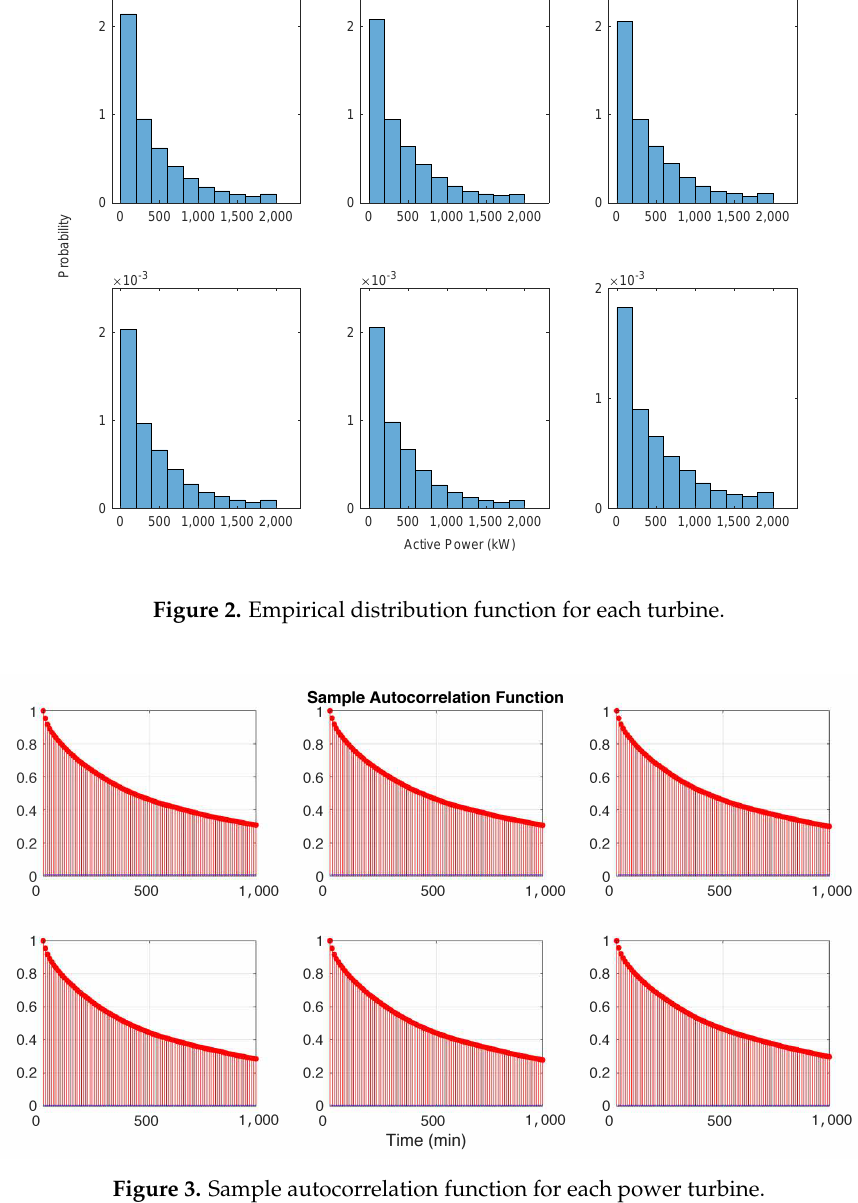
Figure 3. Sample autocorrelation function for each power